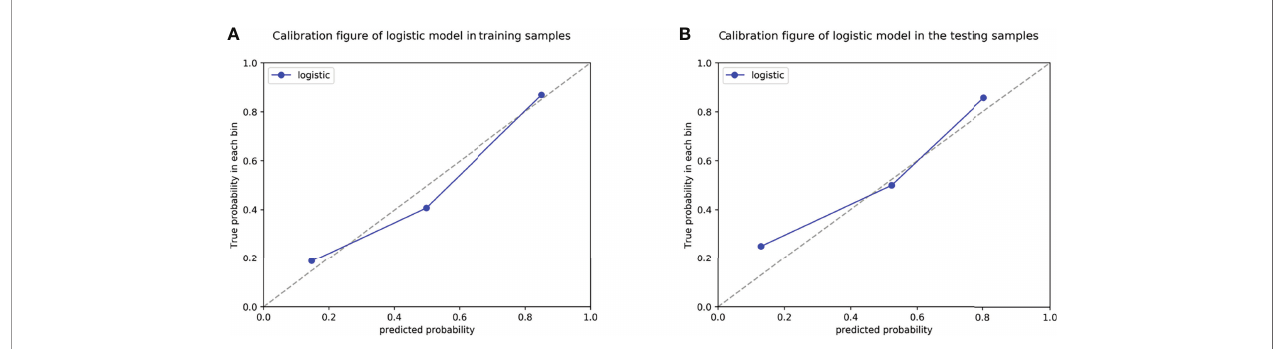
FIGURE 5 | Calibration curves of the radiomics nomogram in the training cohort (A) and validation cohort (B)